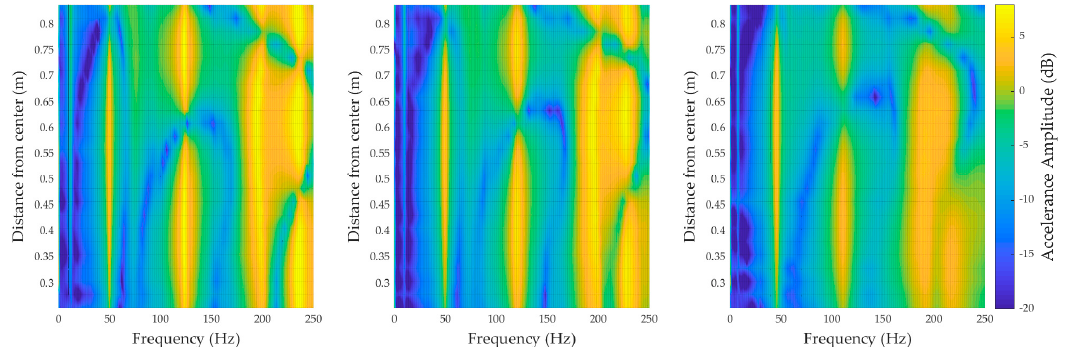
Figure 4. Accelerance maps of a custom ski: ( left ) without any device; ( center ) with the Hero Helper; ( right ) with the